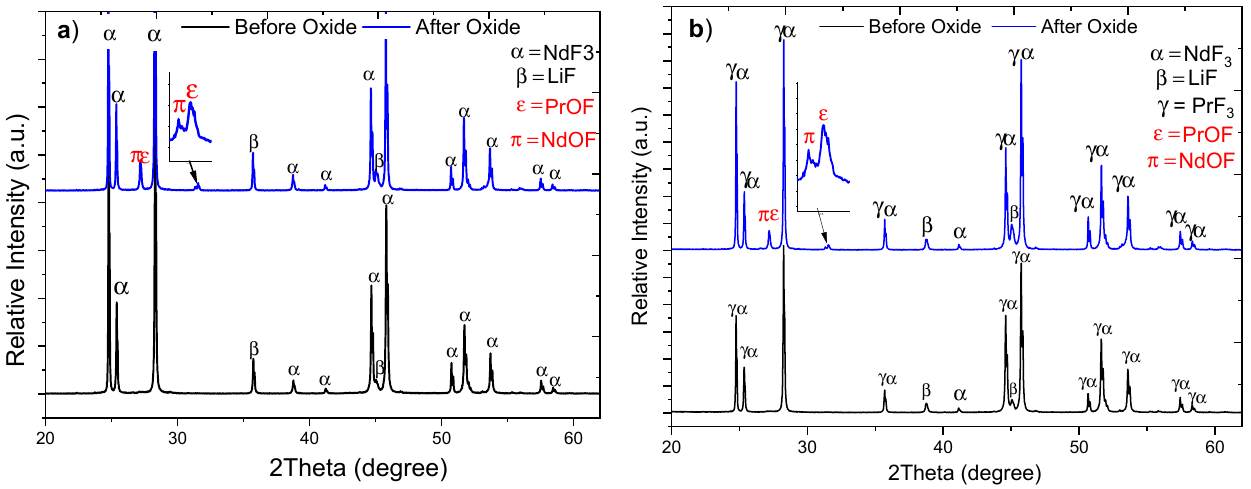
Figure 7. X-ray diffractograms: ( a ) phases present in the solidified electrolyte from dissolving Pr 2 O 3 in an equimolar NdF 3 – LiF electrolyte (experiment 4) showing PrOF and NdOF; ( b ) phases present in the solidified electrolyte from dissolving neodymium and praseodymium oxides (77.5 wt% Nd 2 O 3 –22.5 wt% Pr 6 O 11 ) in a 37.5 mol% NdF 3 –12.5 mol% PrF 3 –50 mol% LiF electrolyte (experiment 8) showing PrOF and NdOF.